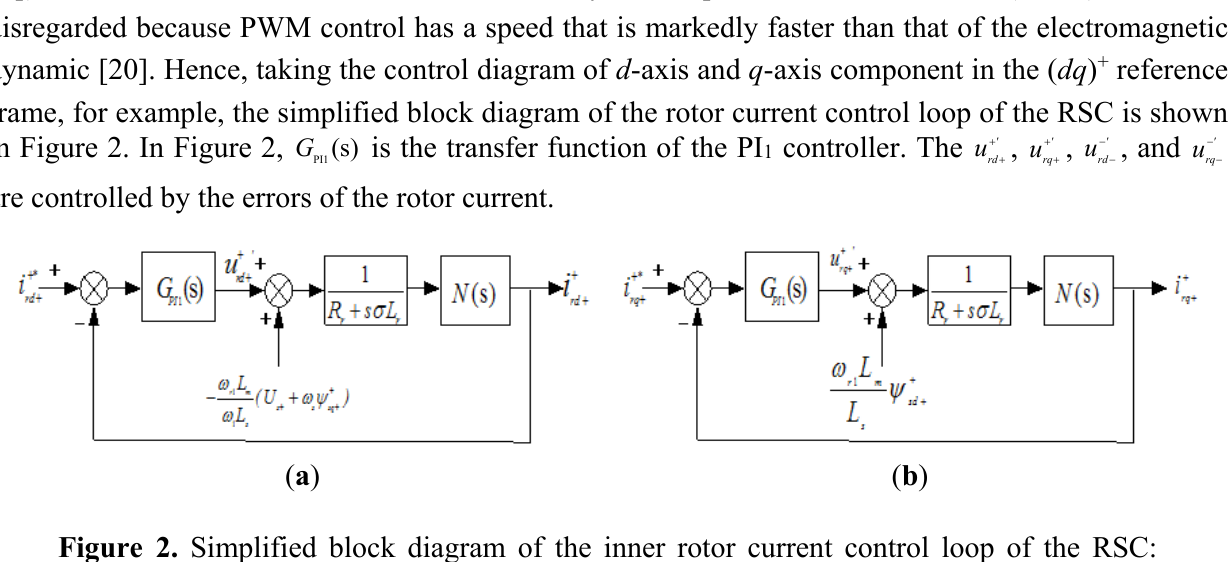
Figure 2. Simplified block diagram of the inner rotor current control loop of the RSC: ( a ) simplified control diagram of the d -axis component in ( dq ) + reference frame; and ( b ) simplified control diagram of the q -axis component in ( dq ) + reference frame. RSC: rotor-side